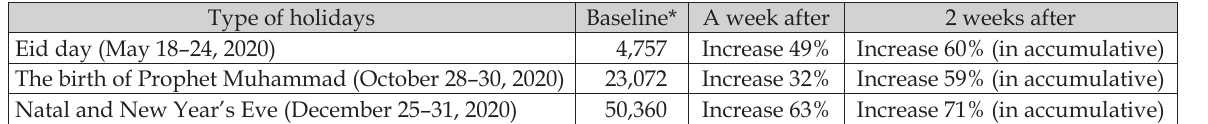
Table 5. Indonesian holidays and the increasing number of positive cases. Type of